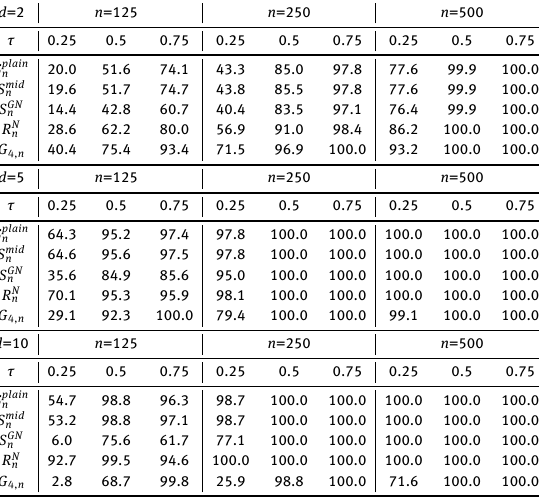
Table 4: Percentages of rejection at 5% significance level, as estimated from 1000 replicates, for the tests based on S plain n , S mid n , S GN n , R N n and G 4, n under the Fisher copula (*Kendall’ τ refers to the associated Student-t